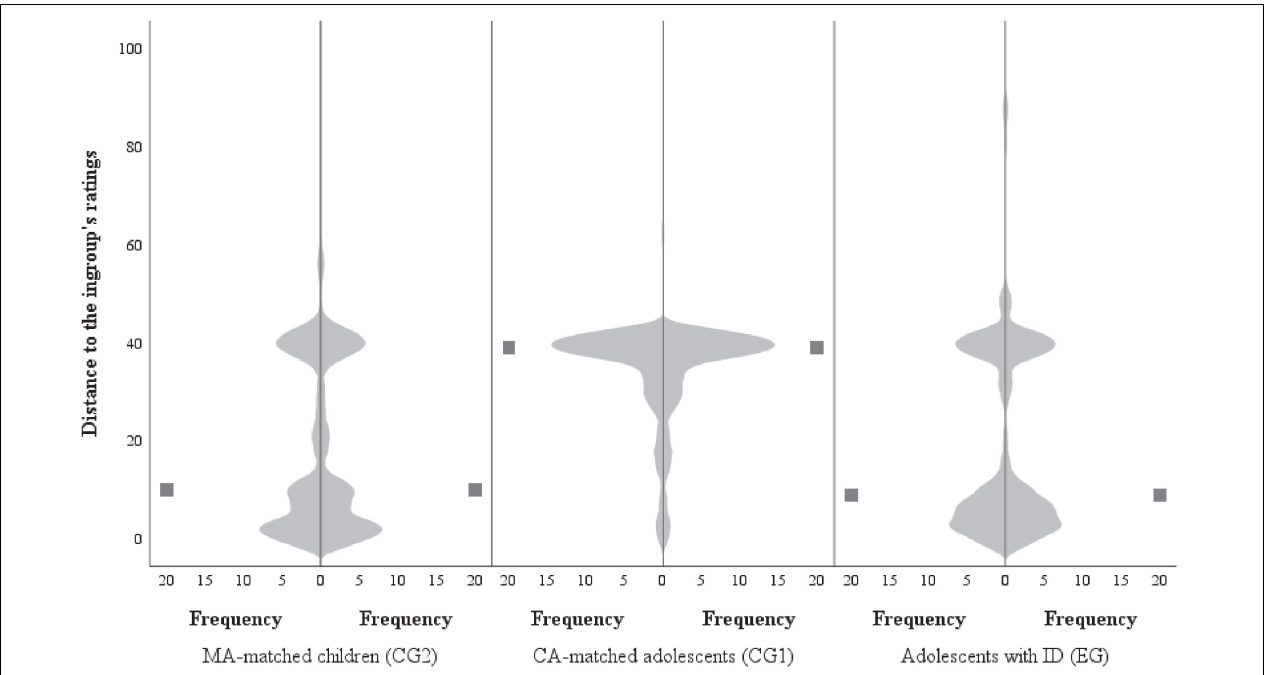
FIGURE 3 | Distance of the participants’ ratings (T2) to ingroup ratings within the three groups. Values close to 0 = participant’s ratings (T2) close to ingroup ratings; values close to 40 = participant’s ratings (T2) close to the participant’s initial ratings (T1); values close to 100 = participant’s ratings (T2) in a large distance to the ingroup ratings. Squares represent the medians. EG, experimental group comprising adolescents with intellectual disability (ID); CG1, comparison group 1 comprising chronological age-matched adolescents without ID; CG2, comparison group 2 comprising younger age-matched children.